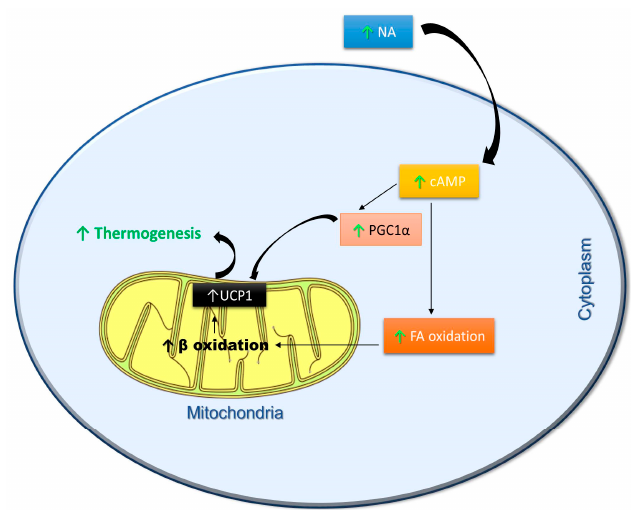
Figure 2. Schematic representation of metabolic pathways stimulated by polyphenols to activate thermogenesis. NA—noradrenaline; cAMP—cyclic adenosine monophosphate; PGC1 α —peroxisome proliferator-activated receptor gamma coactivator 1 α ; FA—Fatty acid oxidation; β oxidation—Beta oxidation; UCP-1—Uncoupling protein 1; ↑ —Polyphenol Induction.